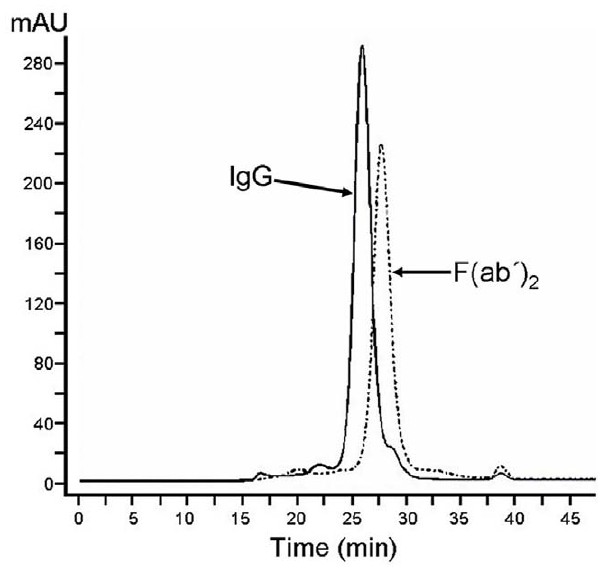
Figure 3. Analysis of antivenoms by gel filtration. Aliquots of the antivenoms were separated by gel filtration in Superdex 200 10/300 GL column and elution was carried out with 150 mM NaCl, 20 mM Tris-HCl, pH 7.5 buffer. Both antivenoms showed a major peak, corresponding to either F(ab’) 2 or IgG monomers, which comprise . 90% of the total